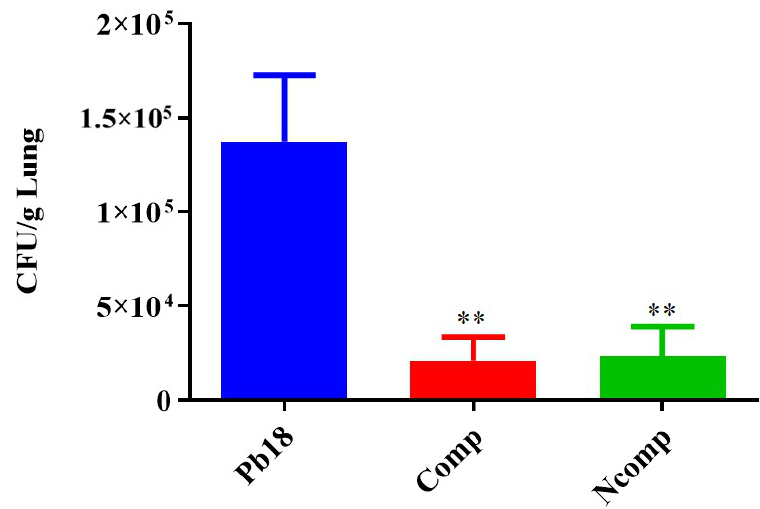
Figure 5. CFU of mice 51 days post infection. The nanoparticle-treated animals had a significant reduction in viable Paracoccidioides cells compared to the Pb 18 group. Pb18 (infected and non- treated), Comp (infected and treated with the P10 complexed nanoparticles) and Ncomp (infected and treated with P10 and with empty nanoparticles). ** = p < 0.01.